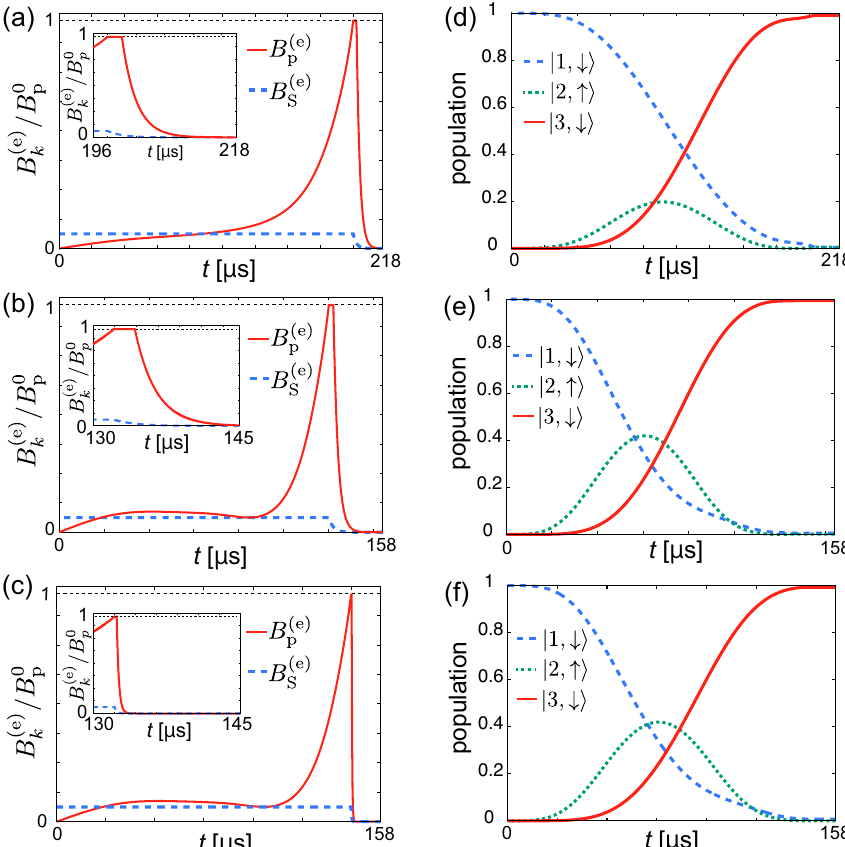
( e ) Figure A1. Envelope functions B for k = p,S normalized by B 0 p for the invariant-based engineering k protocol with ( a ) T stepI = 198 µ s, γ 0 = 0.21, ε = 0.02 and τ = 2 µ s; ( b ) T stepI = 132 µ s, γ 0 = 0.34, ε = 0.02 and τ = 2 µ s; ( c ) T stepII = 132 µ s, γ 0 = 0.34, ε = 0.02 and τ = 0.2 µ s. B 0 p is the maximum amplitude of the pump field. The thin dotted line represents 1. ( d )–( f ) Time dependence of the eigenstate populations corresponding to the envelopes in the left